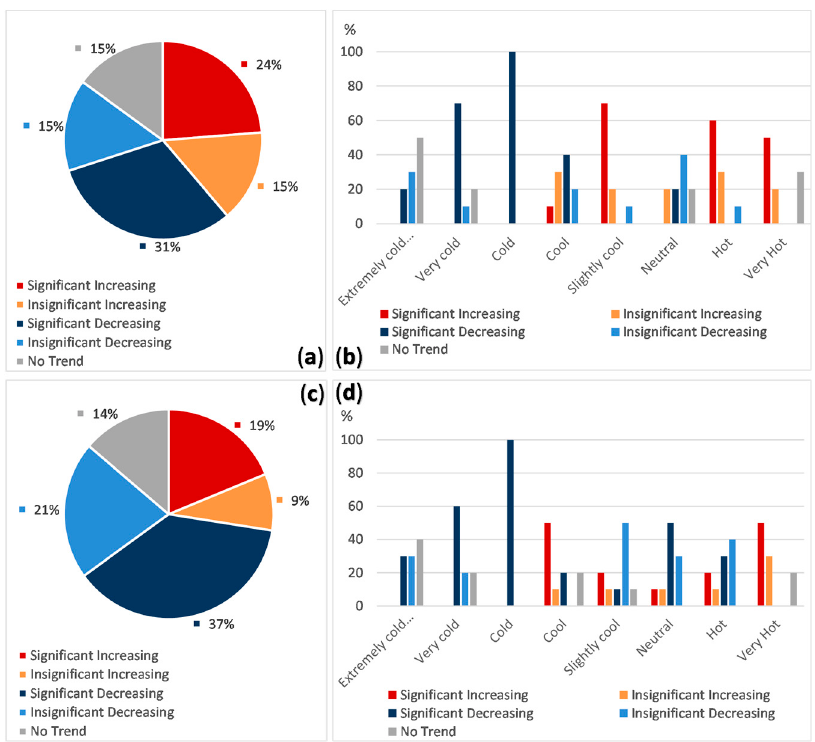
Figure 9. Trend types for the H index: ( a ) for all data sets of FO; ( b ) by thermal sensations classes of FO; ( c ) for all data sets of DOP; ( d ) by thermal sensations classes of DOP. The DOP indicated negative slopes, equally significant and insignificant for the extremely cold class. cities, (e.g., 7 out of 10 for slightly cool conditions) (Figure 10).